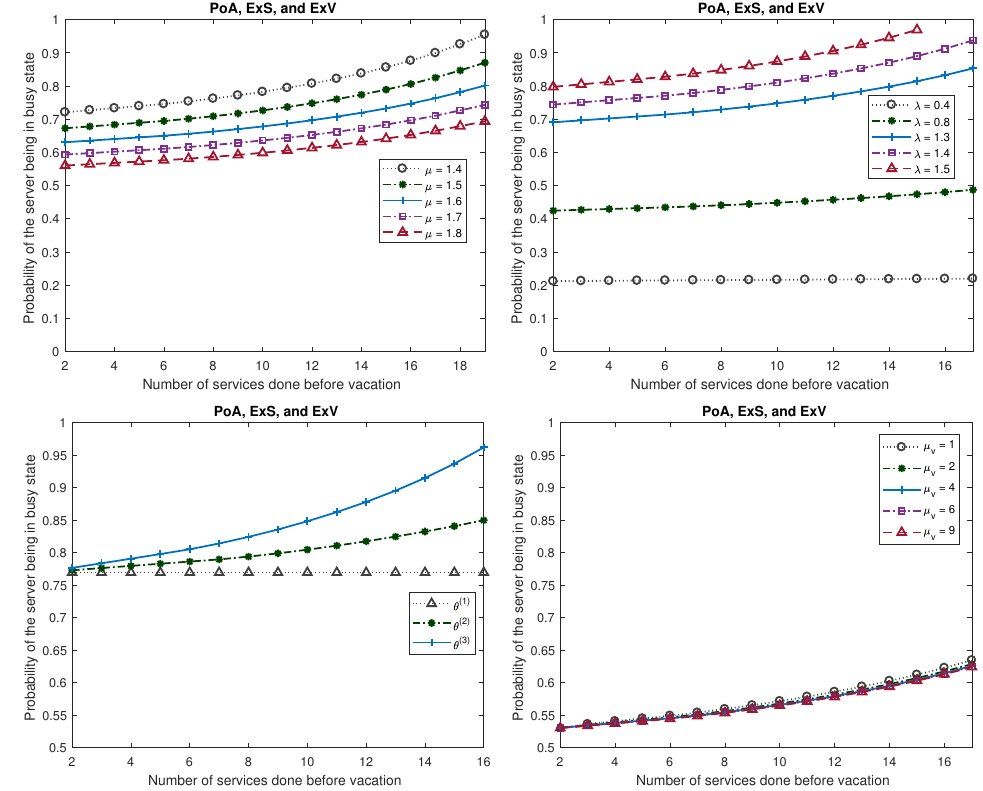
Figure 7. Probability of the server being in busy state (Model